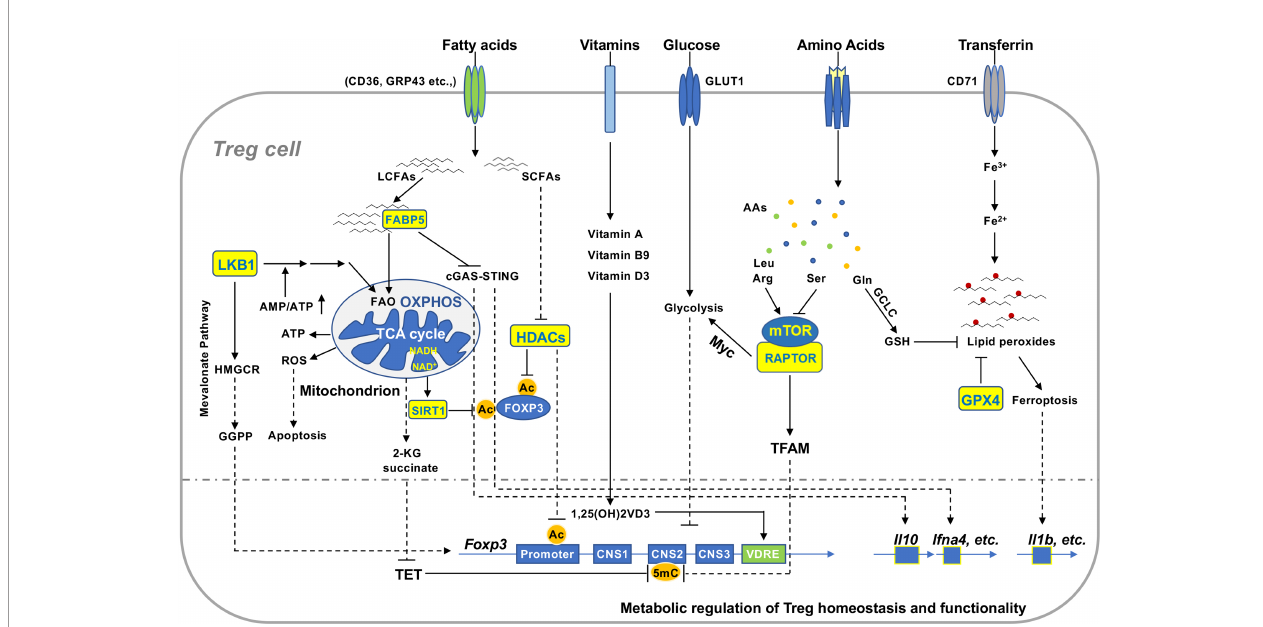
FIGURE 2 | Metabolic signaling in the regulation of Treg homeostasis and function. Extracellular and intracellular metabolites regulate Treg homeostasis and function in various non-lymphoid tissues. Reduced production of ATP activates LKB1 signaling pathway that promotes mitochondrial FAO and OXPHOS and mevalonate pathway producing GGPP, which enhances FOXP3 expression and Treg function. Uncontrolled production of mitochondrial ROS induces Treg apoptosis that facilitates tumor immunoevasion. Increased concentration of cellular NAD + enhances function of the deacetylase SIRT1 that destabilizes FOXP3 protein and compromises Treg function. Tregs take up microenvironmental LCFAs and SCFAs via different receptors. FABP5 binds to LCFAs and transfers them to mitochondria in Tregs. Inactivation of FABP5 activates cGAS-STING to promote expression of IL-10 and type I interferons and Treg function. SCFAs suppress activity of HDACs and thereby maintain acetylated FOXP3 and enhance Treg stability. Vitamin D3 metabolite 1,25(OH) 2 VD 3 -receptor complex binds to VDRE region to enhance Foxp3 gene expression. Distinct amino acids differentially regulate activation of mTOR, which can augment glycolysis to suppress FOXP3 expression via Myc or evoke TFAM function to restrain methylation of CNS2. Activated Tregs elevate uptake of transferrin, which can be converted to reductive iron to facilitate the generation of lipid peroxides. GCLC catalyzes the synthesis of GSH crucial for maintaining cellular redox homeostasis. It functions as a substrate for GPX4 to prevent the accumulation of lipid peroxides in Tregs and subsequent ferroptosis. Ferroptotic Tregs enhance production of pro-in fl ammatory cytokines such as IL-1 b . GGPP, geranylgeranylpyrophosphate; ROS, reactive oxygen species; NAD, nicotinamide adenine dinucleotide; LCFAs, long chain fatty acids; SCFAs, short chain fatty acids; HDAC, histone deacetylase; VDRE, vitamin D response element; CNS2, conserved non-coding sequence 2; GCLC, glutamate cysteine ligase catalytic